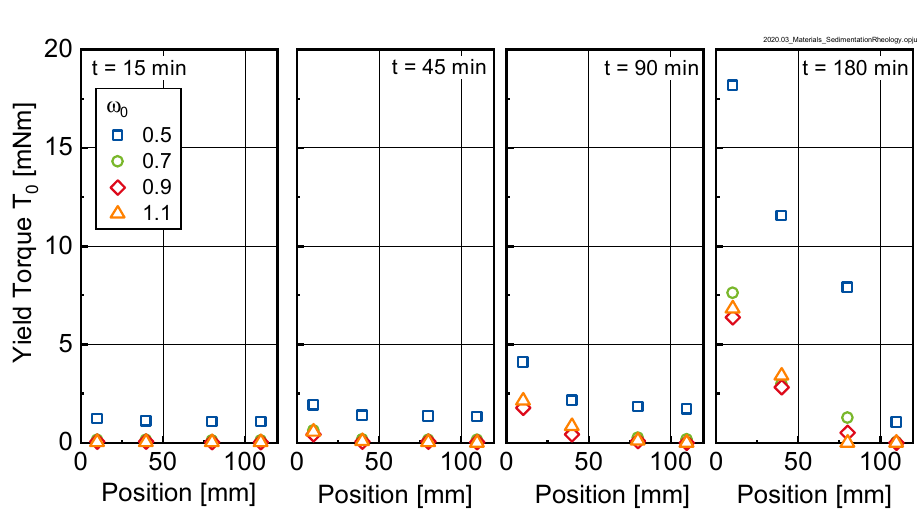
Figure 10. Yield Torque T 0 measured at di ff erent positions for di ff erent points in time for initial w / c-ratios ω 0 of 0.5, 0.7, 0.9 and 1.1, respectively. Table 2. Regression parameters A and B as determined by fitting Equation (4) to the data shown in Figure 11.